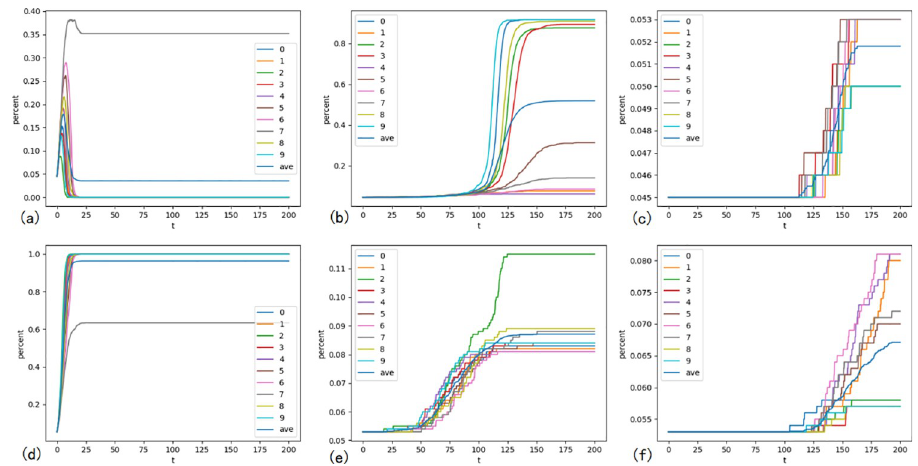
Fig 10. Starting from the same initial setting and group distribution, and based on benchmark setting but with γ 0 = − 0.42, n = 10. (a)–(c) shows 10 individual evolutions and also the average change tendency of I percent for information No. 0, 2, 4, respectively, while (d)–(f) shows the corresponding results to (a)–(c) for R percent evolution, respectively.